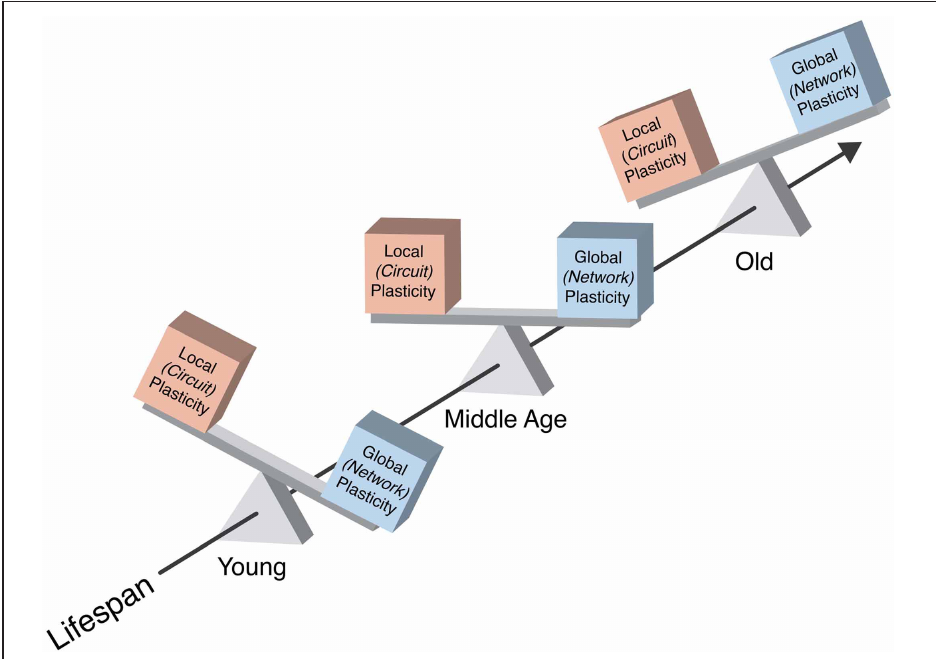
FIGURE 1 | Schematic representation of the balance between local and network plasticity and its change across a typical lifespan. A functionally “normal” brain is a changing brain, a brain whose capacity and mechanisms of change are shifting appropriately from one time-point in life to another. In health, local cortical and network plasticity might keep a fine-tuned balance, which optimizes